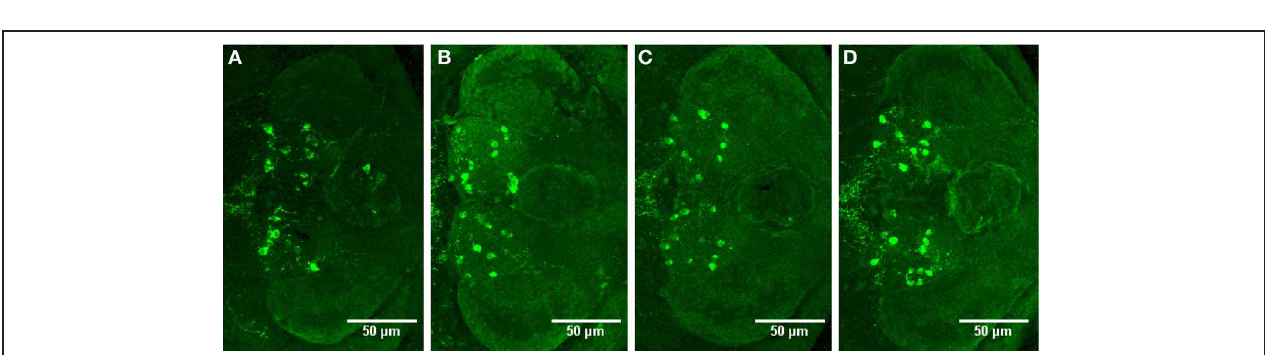
FIGURE 2 | The levels of th1 , th2 , and hdc mRNA after a 10-min ethanol treatment. A clear dose-dependent trend can be seen for all mRNA species analysed. Statistical significance was analysed using One-Way ANOVA followed by Tukey’s post-hoc test. (A)